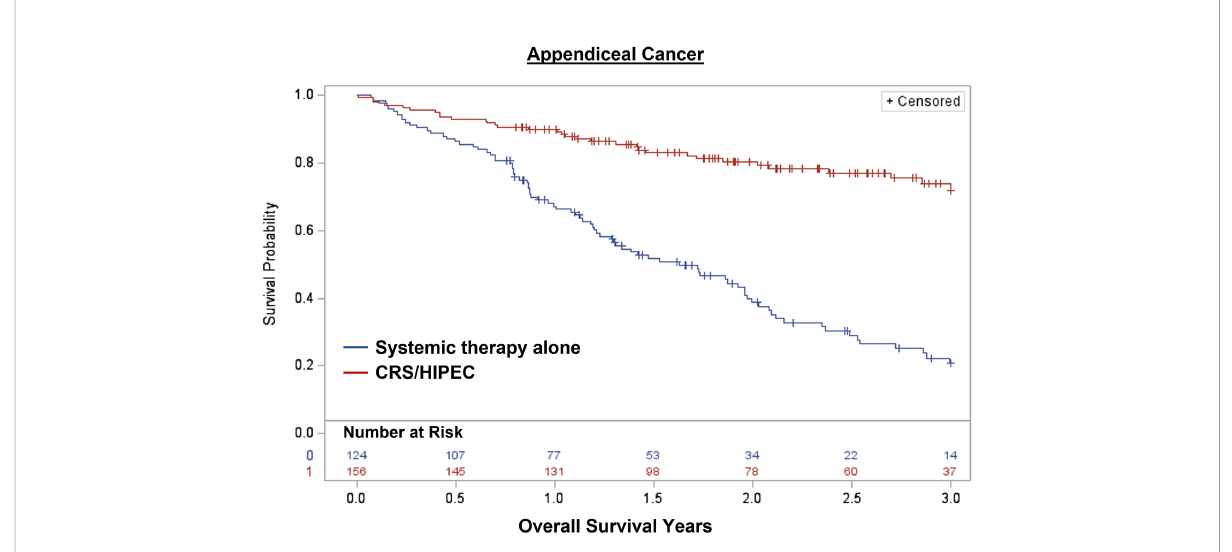
FIGURE 2 Kaplan-Meier 3-year overall survival of 280 patients with appendiceal cancer and peritoneal metastasis strati fi ed by treatment with CRS/HIPEC +/- systemic therapy or systemic therapy